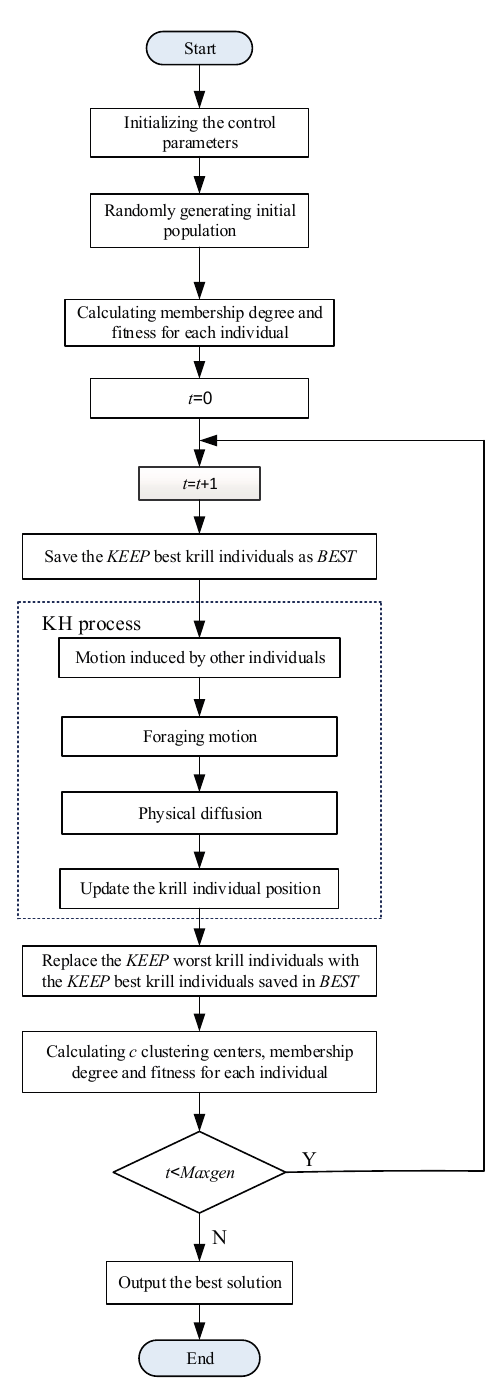
Figure 1. Flowchart of FCM algorithm by using the KHE